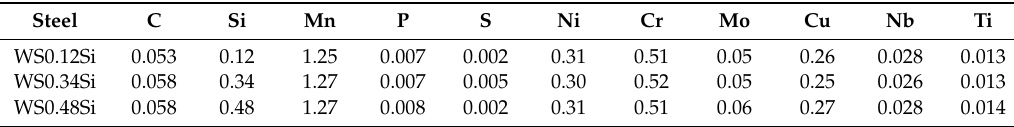
Table 1. Chemical compositions of the test